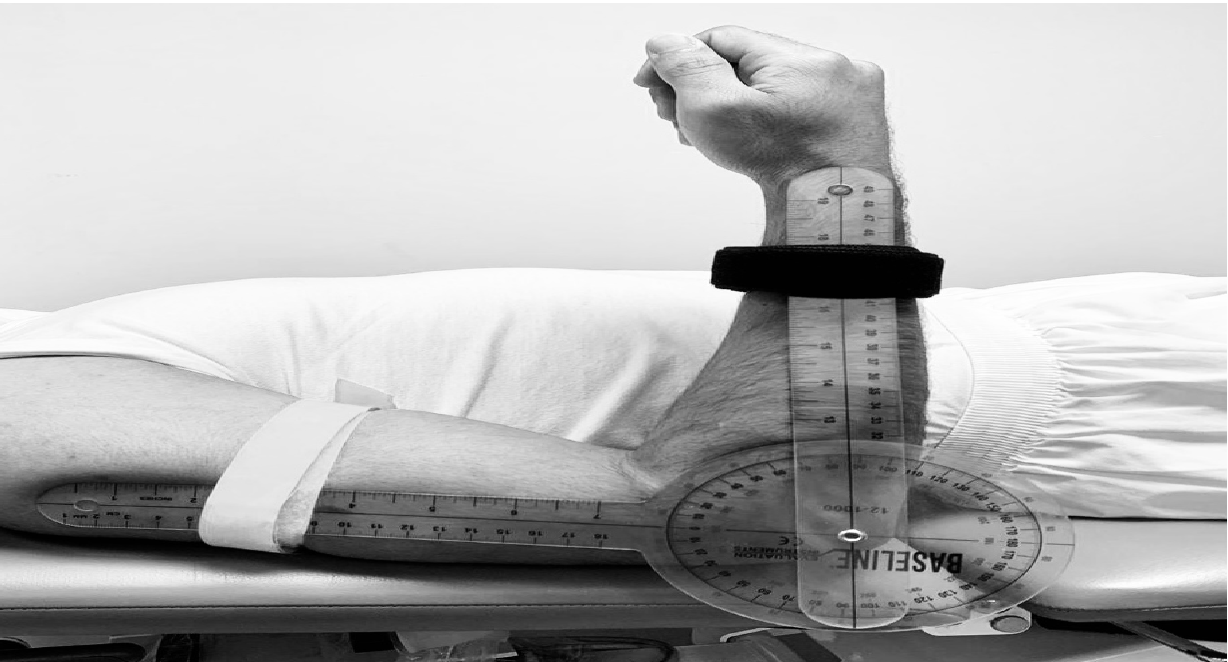
Figure 2. Range of motion measurement with goniometer.